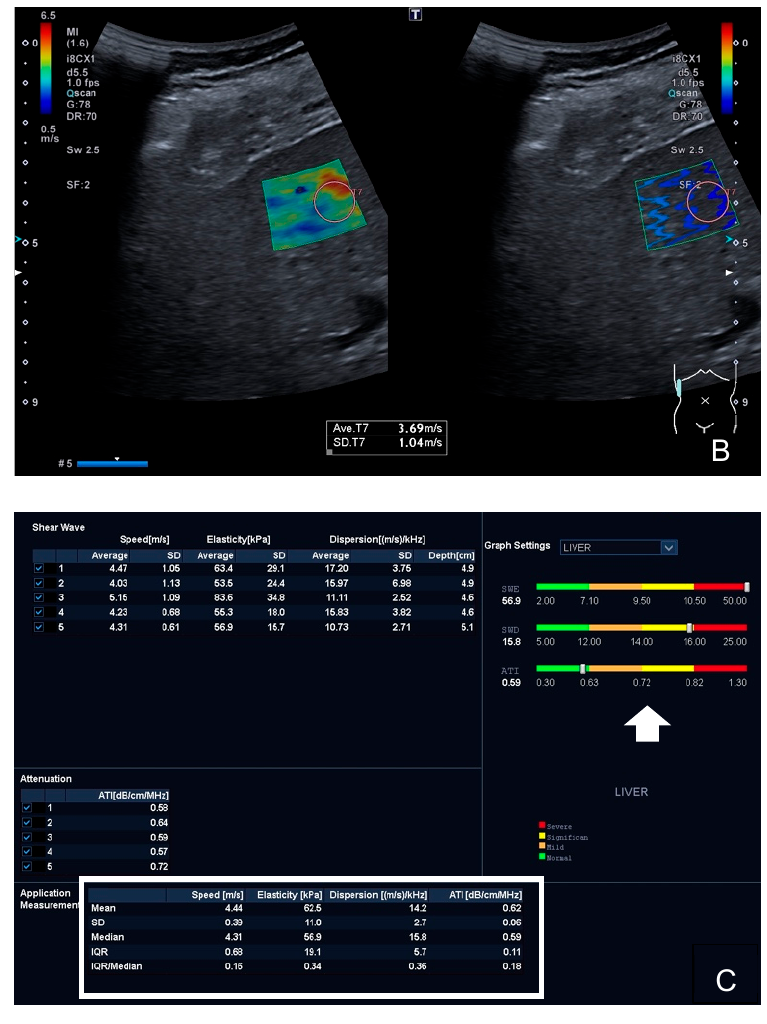
Figure 1. Intercostal view in an SWE application (left in ( A , B )) with corresponding shear-wave dispersion (right in ( A , B )) in a patient with severe liver fibrosis/cirrhosis. ( A ) displays a color-coded elastogram representing the elevated stiffness (red colorization of the sample window), which was confirmed in quantification measurements after placing a sample ROI inside the SWE box which presented stiffness values of 63.4 kPa and an SWD of 14.2 m/s/kHz ( C ). ( B ) shows the corresponding SWS mapping of the same patient with an inhomogenously colored elastogram, representing elevated shear-wave speed values in this case of advanced cirrhosis, which was confirmed in quantitative analysis (SWS = 3.69 m/s). The validity of acquired measurements was confirmed using the dispersion slope form as a quality indicator. Figure 1C provides corresponding quantitative “liver analysis” results: mean and median values ( ± sd) of the SWE, the SWD and the ATI were calculated (white box), and the classification of individual findings was performed according to the color-coded scale (white arrow). This patient’s measurements were classified as “severe” considering the SWE, “significant” considering the SWD and “normal” considering the ATI analysis, suggesting the presence of severe fibrosis or cirrhosis but only little inflammation or